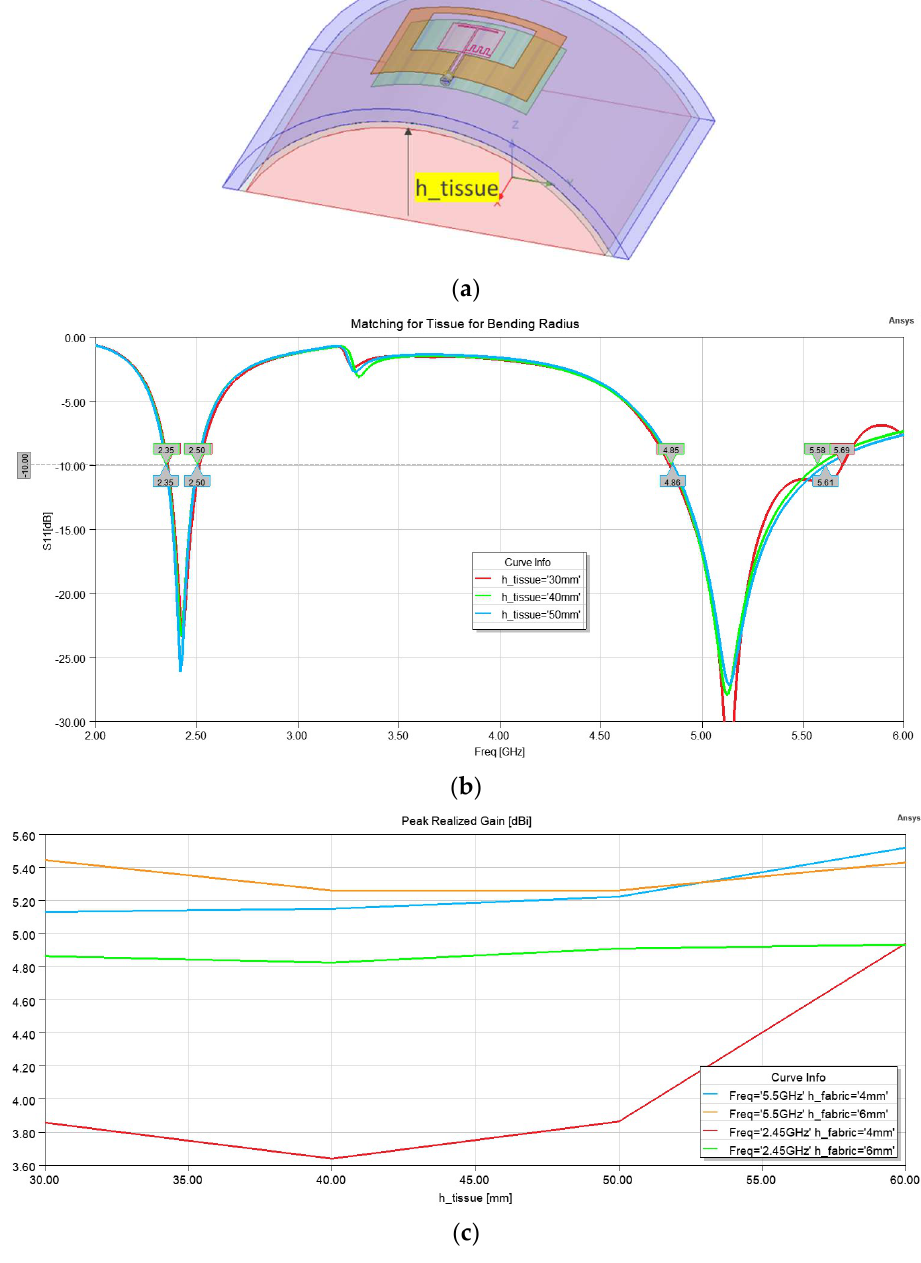
Figure 7. Antenna performance under bending condition (simulation): ( a ) Bending profile; ( b ) S11 under various bending radii (h_tissue); ( c ) gain variation vs. bending radii ( ℎ_𝑡𝑖𝑠𝑠𝑢𝑒 ) for the antenna on 4 mm and 6 mm substrates at 2.45 GHz and 5.5 GHz.